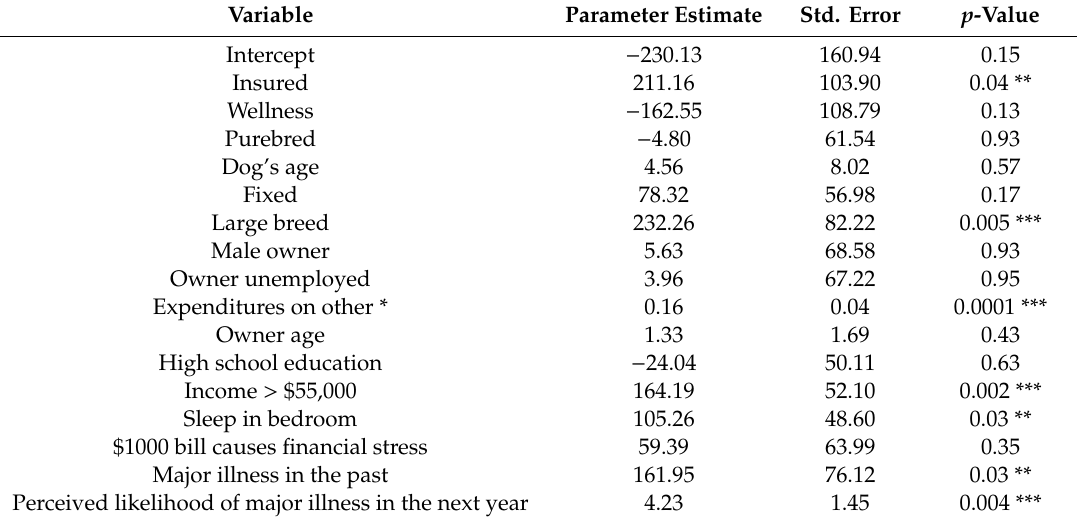
Table 3. Ordinary least squares (OLS) regression results with total expenditures as the dependent variable. Variable